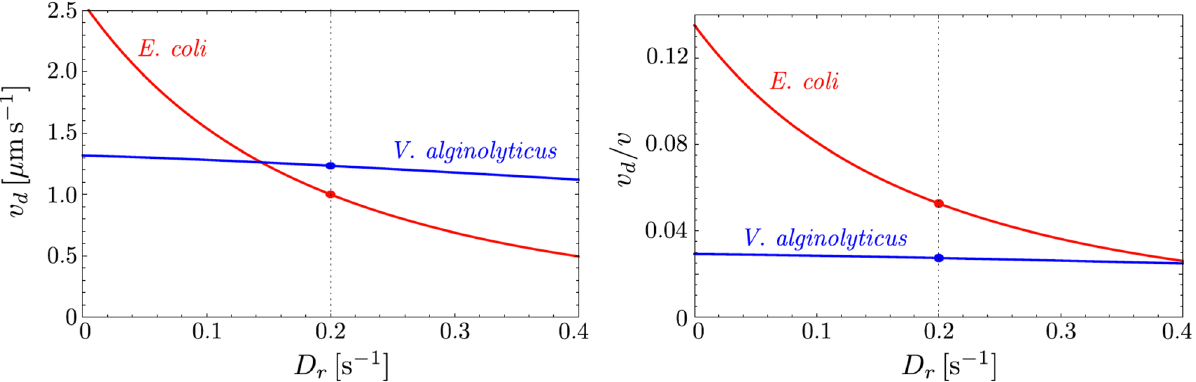
Figure 6. Chemotactic drift speed as a function of D r for E.coli and V.alginolyticus . The plot on the left shows v d ; on the right, the chemotactic drift is normalized by the swimming speed as v d = v and coincides with the chemotactic index.